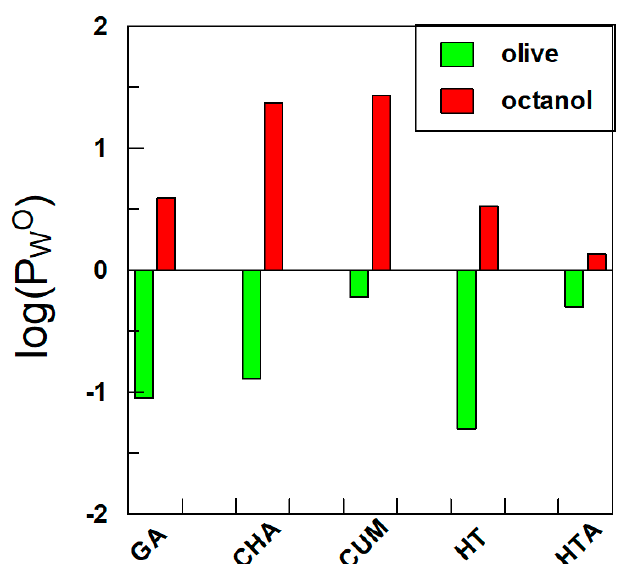
Figure 3. Comparison between the experimentally determined P WO values in oil–water systems and the theoretical P WOctanol values for a series of antioxidants with different molecular structures.